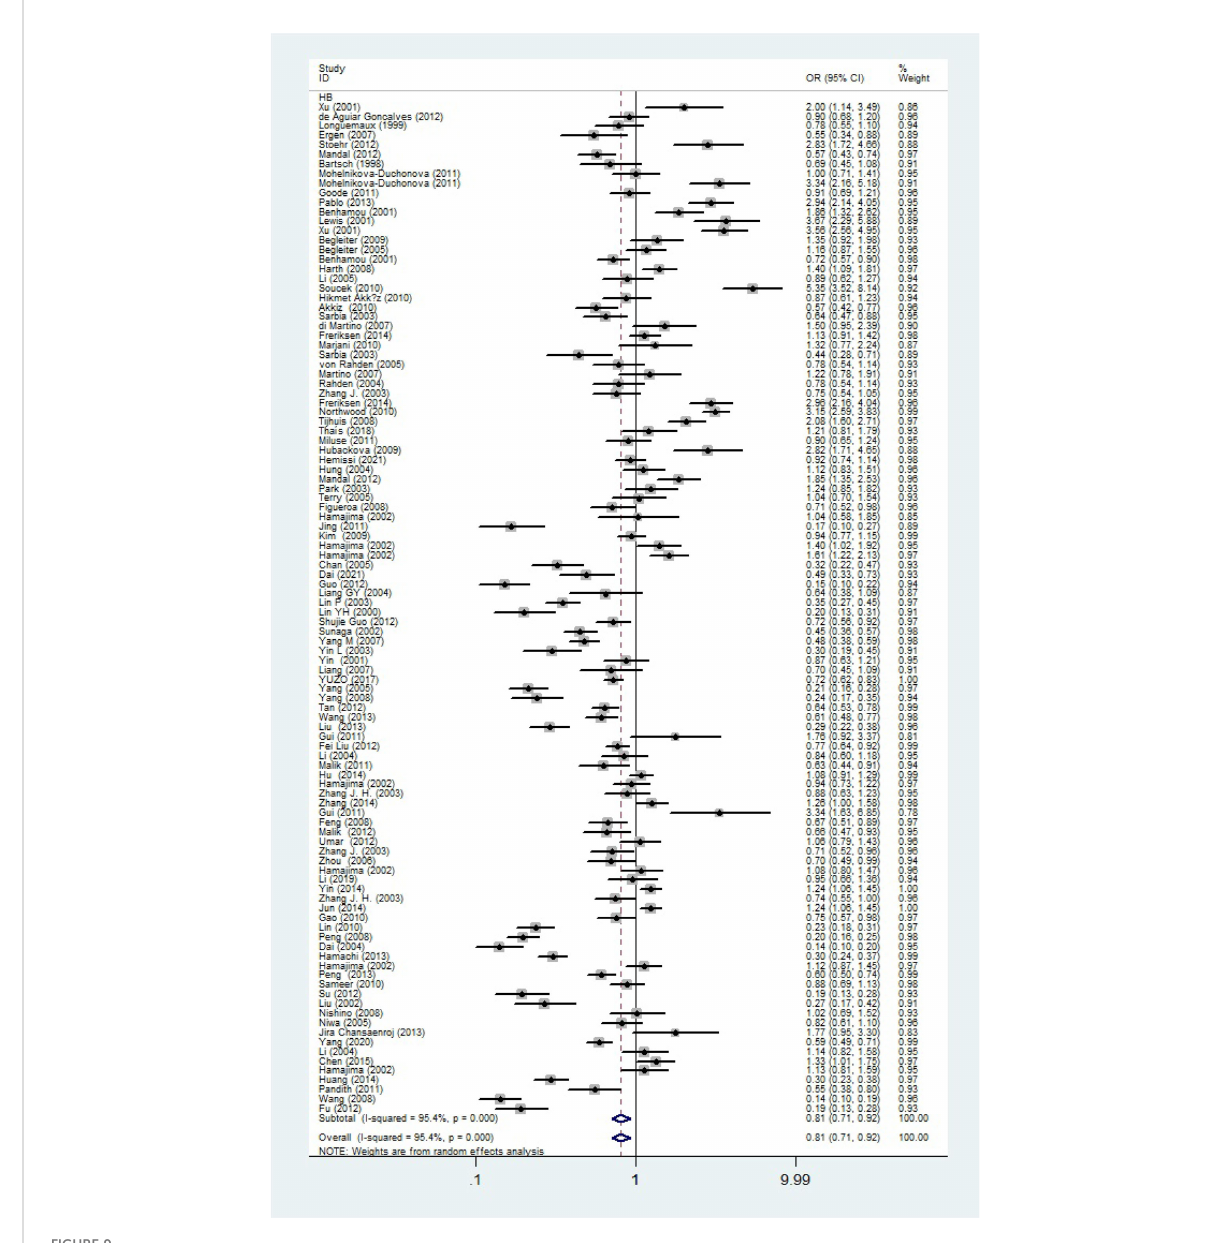
FIGURE 9 Forest plot about association between NQO1 gene rs1800566 polymorphism in HB subgroup (C-allele vs. T-allele model). There were signi fi cantly decreased association between NQO1 polymorphism in HB subgroup. The squares and horizontal lines correspond to the study-speci fi c OR and 95% CI. The area of the squares re fl ects the weight (inverse of the variance). The diamond represents the summary OR and 95%